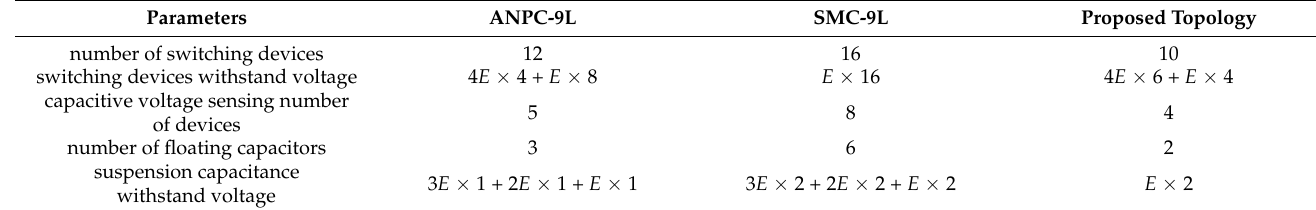
Table 2. Parameters comparison of the main circuit.